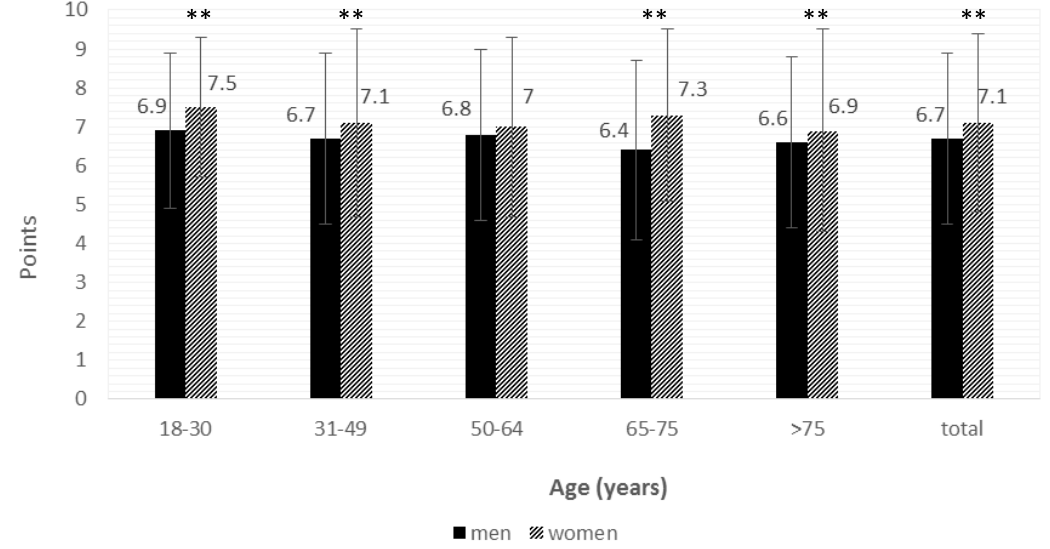
Figure 2. The average population that enjoys cooking, on a scale from 1–10. The sample sizes by age groups were as follows: 18–30 years: 131 men and 189 women; 31–49 years: 332 men and 469 women; 50–64 years: 185 men and 275 women; 65–75 years: 84 men and 134 women; >75 years: 71 men and 156 women. ** p < 0.01, women vs. men. Table 1. Binary logistic regression for the main cooking responsibilities. Odds Ratio p CI (95%)